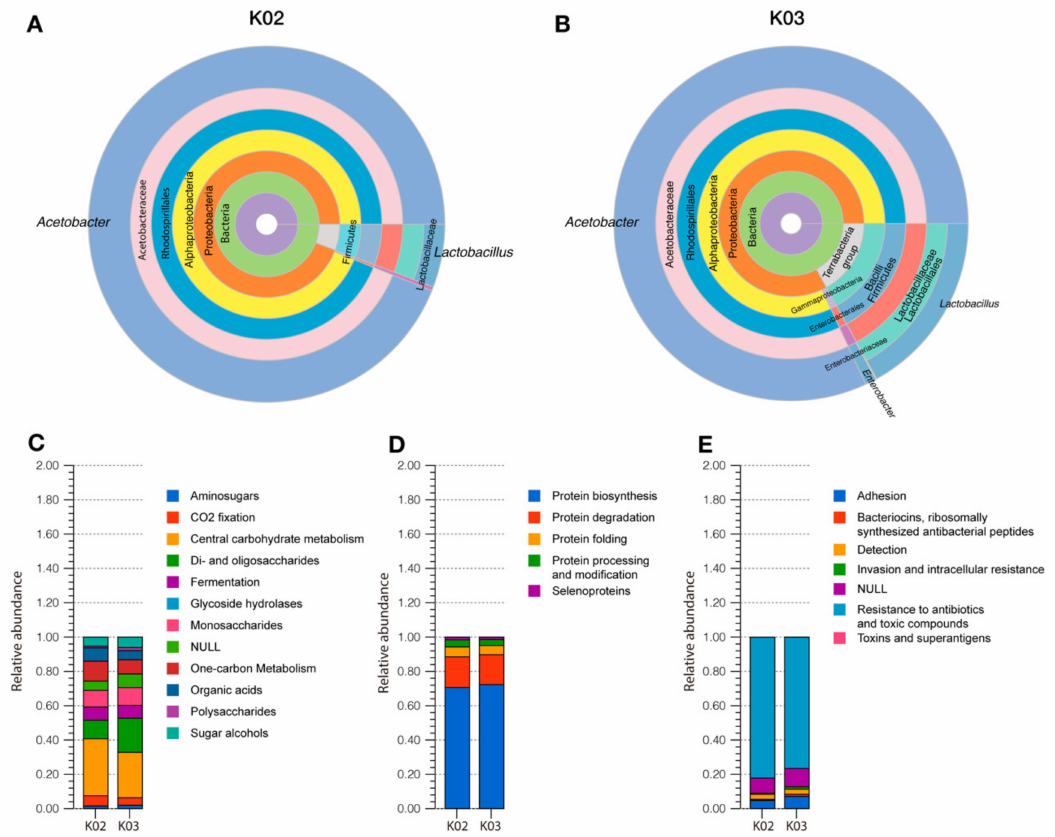
Figure 1. Taxonomic and metagenomic features of kefir beverages. Bacterial taxonomic analysis of the metagenomes of kefir beverages through 16S rDNA sequencing, represented as bacterial relative abundance ( A , B ). Subsystem analysis of kefir beverages metagenomes: Carbohydrates ( C ), Protein metabolism ( D ), and Virulence, Disease, and Defense ( E